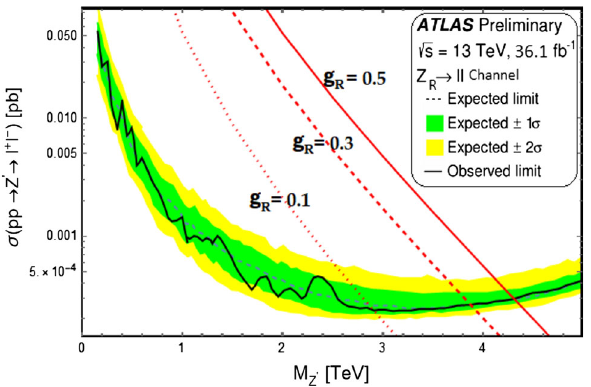
Fig. 12 Upper limits at 95% C.L. on the cross-section for the process pp → Z (cid:2) → l + l − as a function of the di-lepton invariant mass using √ s = 13 TeV with 36.1 fb − 1 integrated luminosity. ATLAS results at The black solid line is the observed limit, whereas the green and yellow regions correspond to the 1 σ and 2 σ bands on the expected limits. Red solid (dashed) [dotted] line is for model predicted cross-section for this different values of U ( 1 ) R gauge coupling constant g R = 0 . 5 ( 0 . 3 ) [ 0 . 1 ] respectively